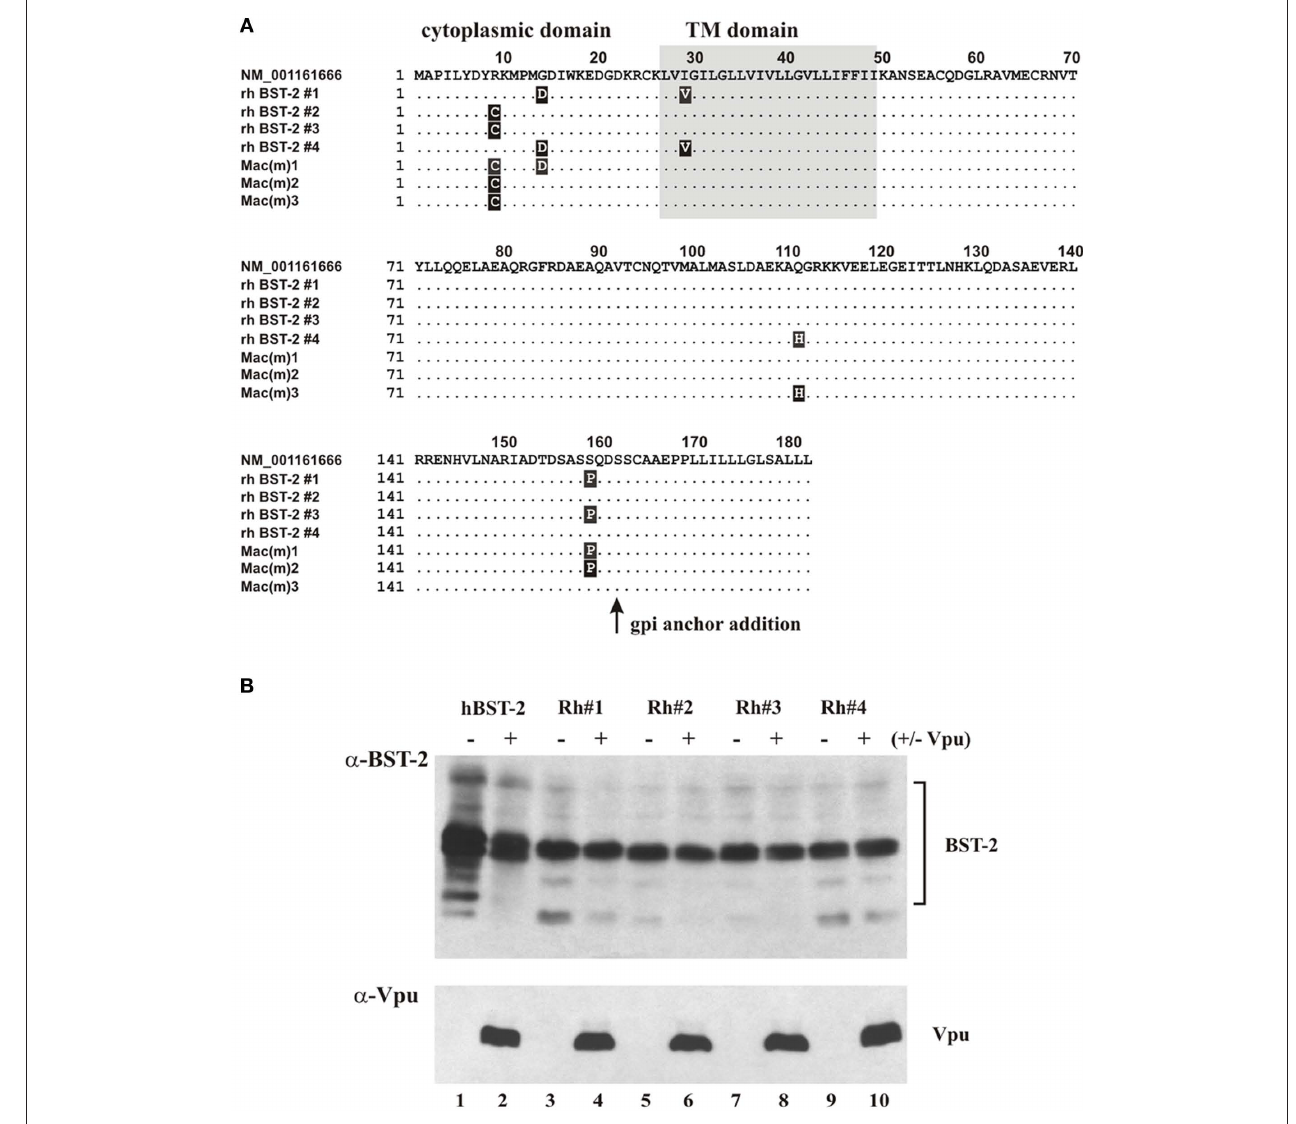
FIgure 1 | Cloning, expression, and Vpu sensitivity of rhesus BST-2. (A) Rhesus BST-2 was cloned from pooled rhesus macaque RNA by RT-PCR as described in Section “Materials and Methods.” Four independent clones (rh BST-2 #1 to rh BST-2 #4) were sequenced and aligned against the GenBank entry for Macaca mulatta BST-2 (top row). Sequences of three recently published rhesus BST-2 variants [Mac(m)1 to Mac(m)3; McNatt et al., 2009] were coaligned for comparison. Amino acid identities are indicated as